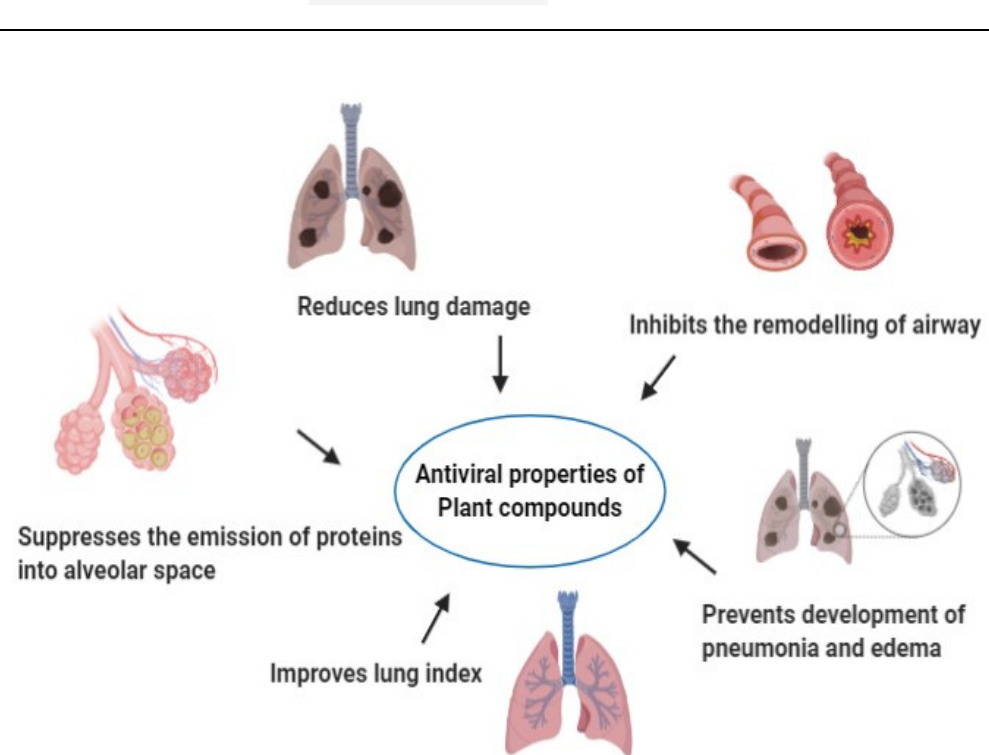
Figure 4. Antiviral properties of plant compounds.